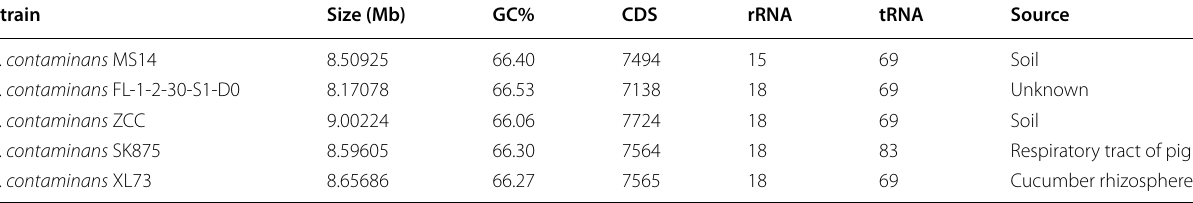
Table 1 Comparison of genomic features of B. contaminans SK875 and other strains